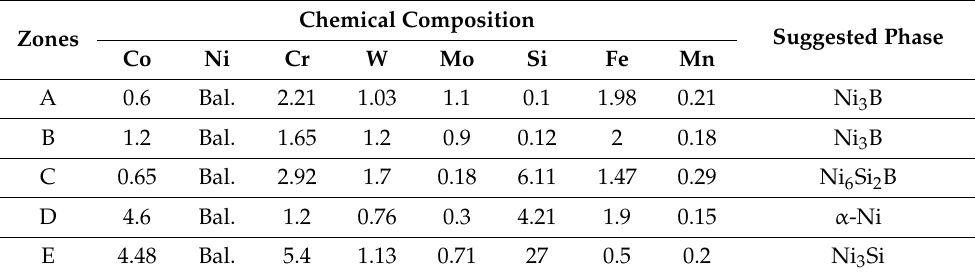
Chemical Composition